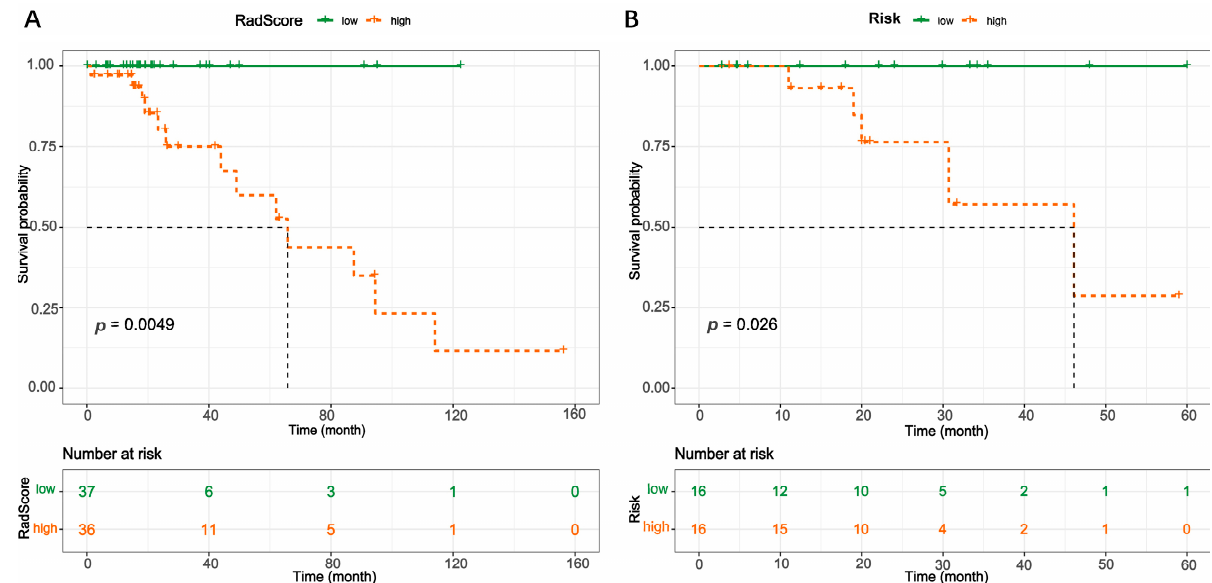
Figure 6. Kaplan–Meier curves with isocitrate dehydrogenase-mutant low-grade glioma. ( A ) Training set and ( B ) Validation set. Mortality was higher in the high-risk group, whereas almost no patients died in the low-risk group ( p -value was 0.026 in the training group and 0.0049 in the validation group). The number at risk means the number of people in the high and low groups who were not censored from the endpoint event at di ff erent times.